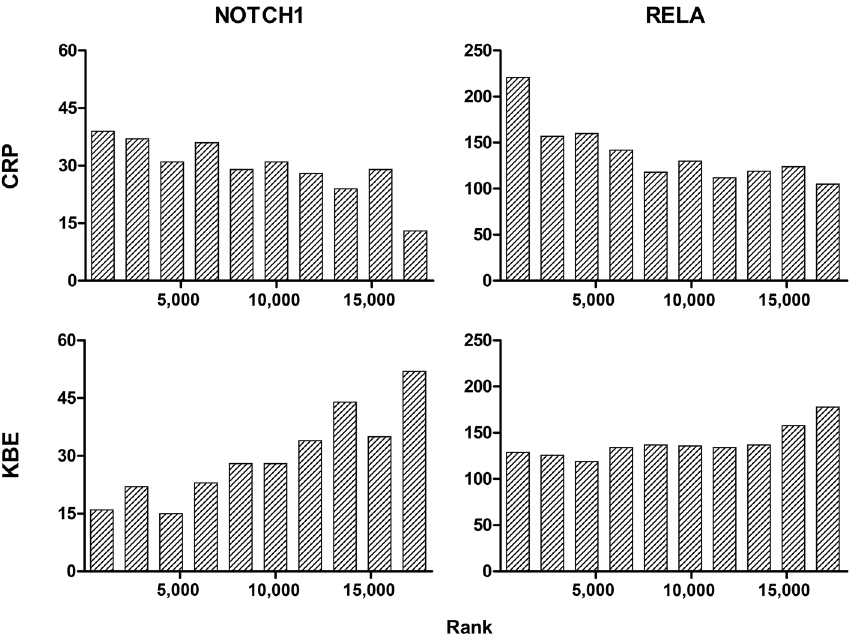
Figure 3: Histograms of the rankings obtained from CRP (top row) and KBE (bottom row) for the NOTCH1 (first column) and RELA (second column) datasets. CRP outperforms KBE, since the histograms for CRP are more right skewed than those for